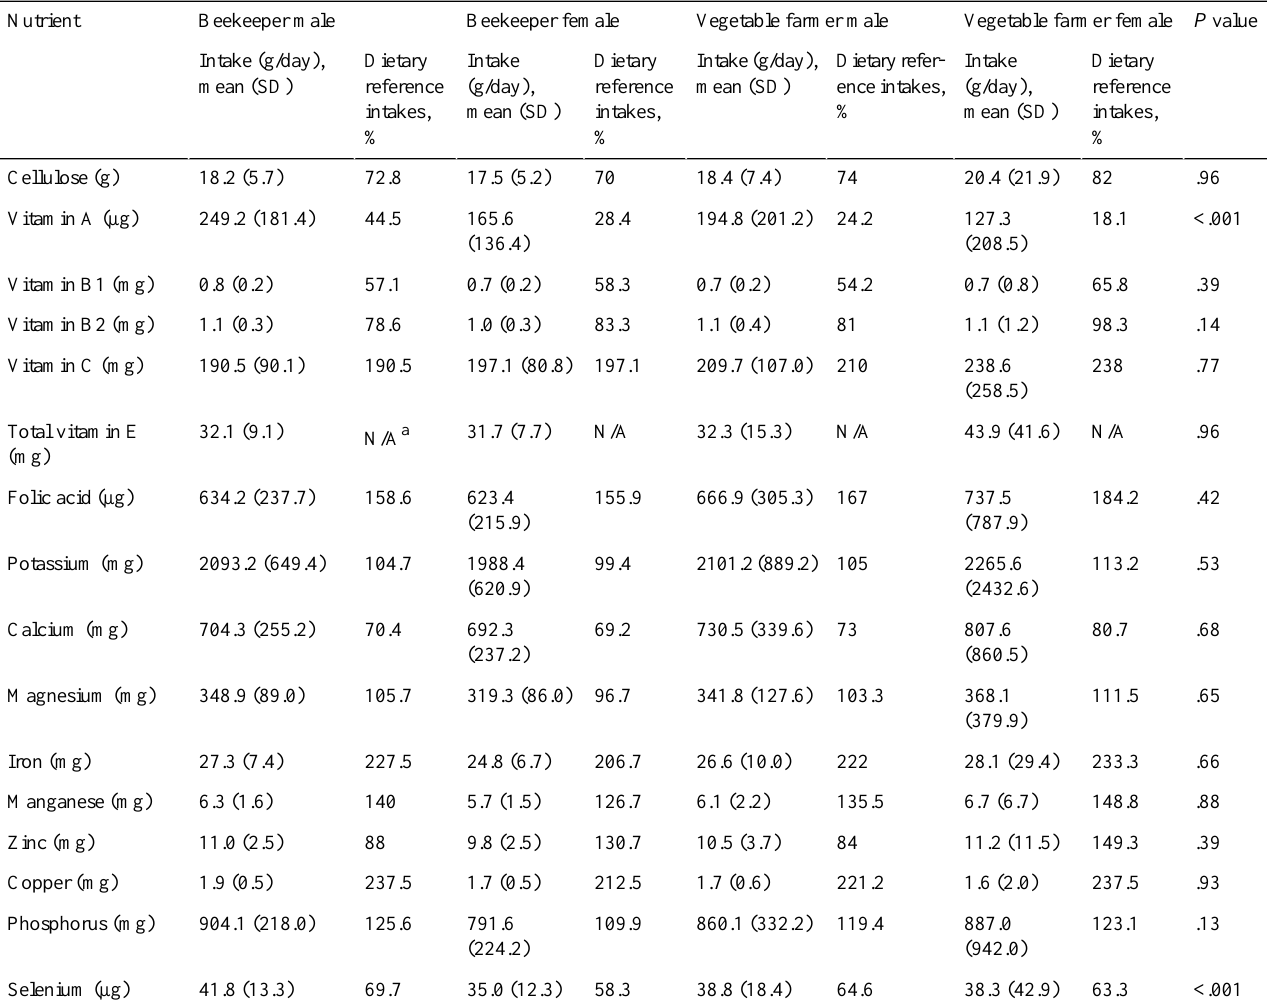
Table 5. Comparing average daily intakes for other nutrients between beekeepers and vegetable farmers from Wuhan, China (sampled period February-April 2016).